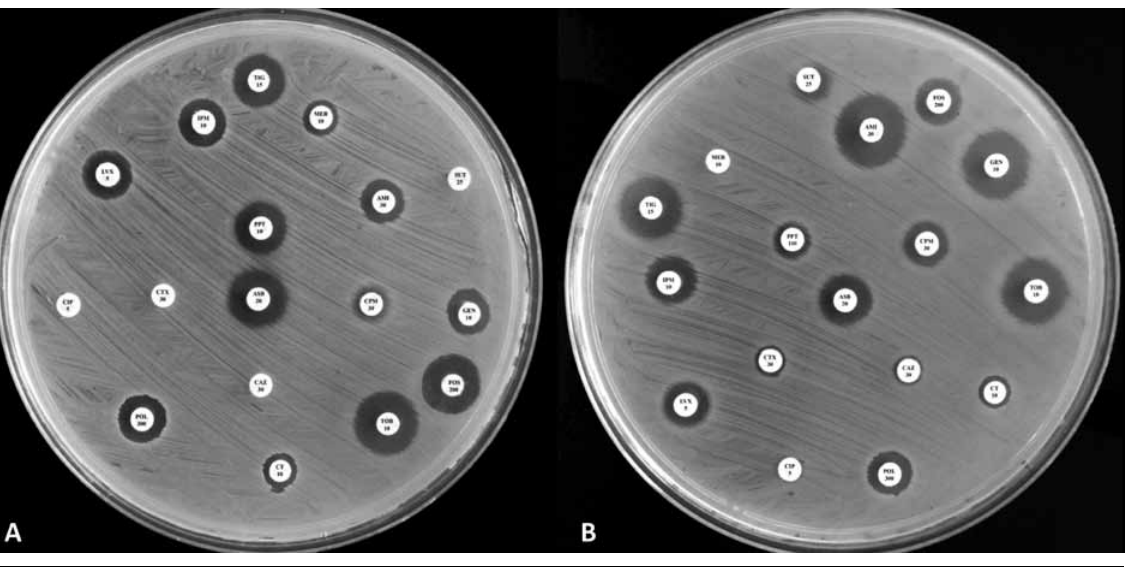
figurE – Antibiogram (Kirby-Bauer ) of MR Acinetobacter baumannii strain A) OXA -23 – producing Acinetobacter baumannii , sensitive only to TOB, ASB and FOS; B ) OXA -143 – producing Acinetobacter baumannii sensitive only to GEN, AMI and TOB. The tested antibiotics correspond to TIG - 15 µg; MER - 10 µg; IPM - 10 µg; PPT -10 µg; AMI - 30 µg; SUT - 25 µg; ASB - 20 µg; CPM - 30 µg; GEN - 10 µg; FOS - 200 µg; TOB - 10 µg; CAZ : 30 µg; CT - 10 µg; CIP - 5 µg, CTX - 30 µg; LVX - 5 µg. MR: multi-resistant; OXA: oxacillinase; TIG: tigecycline; MER: meropenem; IPM: imipenem; PPT: piperacillin / tazobactam; AMI: amikacin; SUT: sulfamethoxazole; ASB: ampicillin/sulbactam; WITH: cefepime; GEN: gentamicin; FOS: fosfomycin; TOB: tobramycin; CAZ: ceftazidime, CT: colistin, CIP: ciprofloxacin; CTX: cefotaxime; LVX: